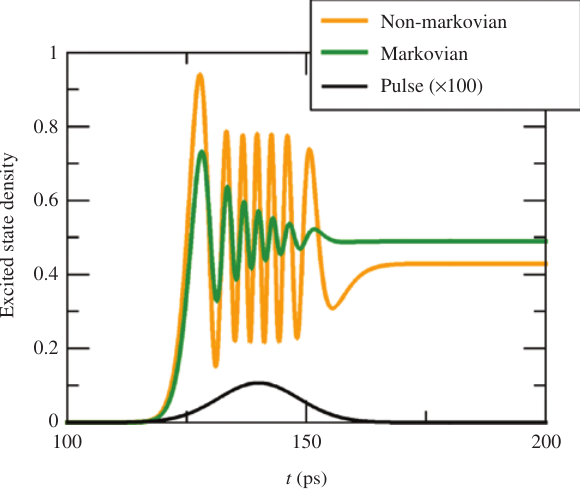
Figure 4: Rabi oscillations of a QD under time-dependent driving (Gaussian pulse, black line).